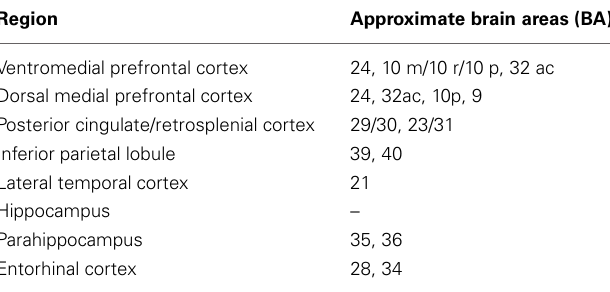
Table 3 | Core cortical components active in the default mode network.